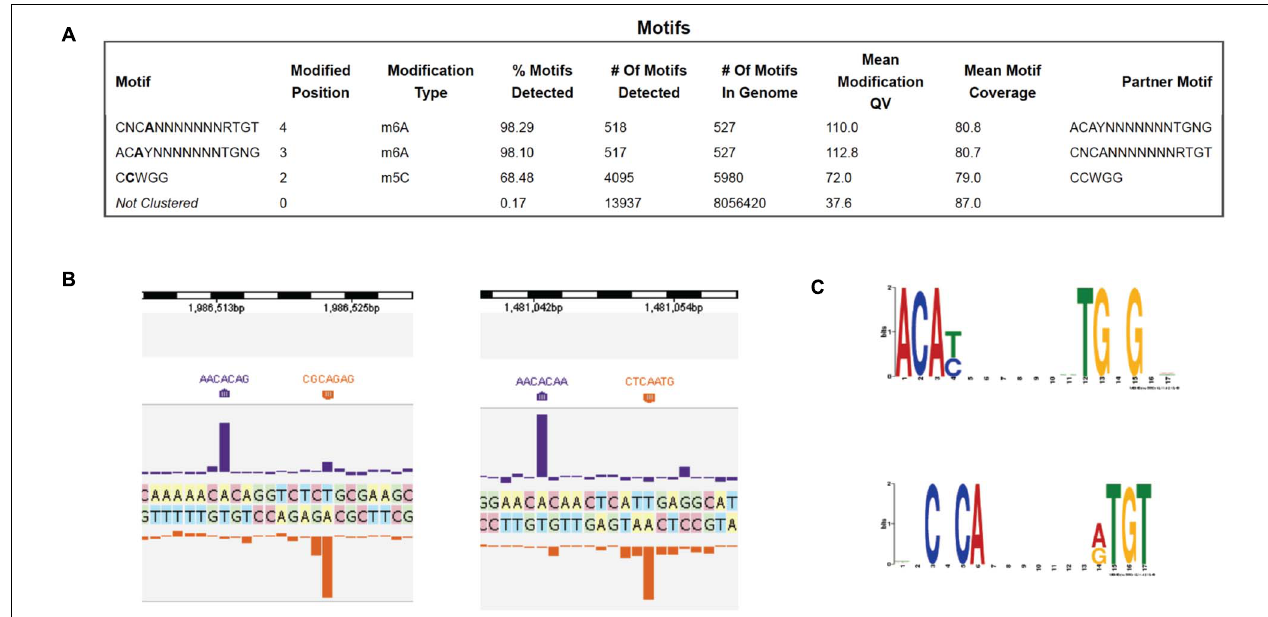
FIGURE 1 | PacBio SMRT sequencing to determine the DNA methylome of B. subtilis T30 genome. (A) Modified DNA sequence motifs identified by interpulse duration (IPD) ratio and percentage of modified sites: M.BisII (98.1 to 98.3%); M.BisIII (68.5%). (B) Two examples of BisII sites modified by M.BisII (6 mA). (C) The M.BisII consensus recognition sequence derived from over 500 modified sites. The M.BisII (HsdM/HsdS) target recognition domain TRD1 and TRD2 specificities are ACAY (complement RTGT) and TGNG (complement CNCA), respectively. The 7-bp Type I restriction system is a new